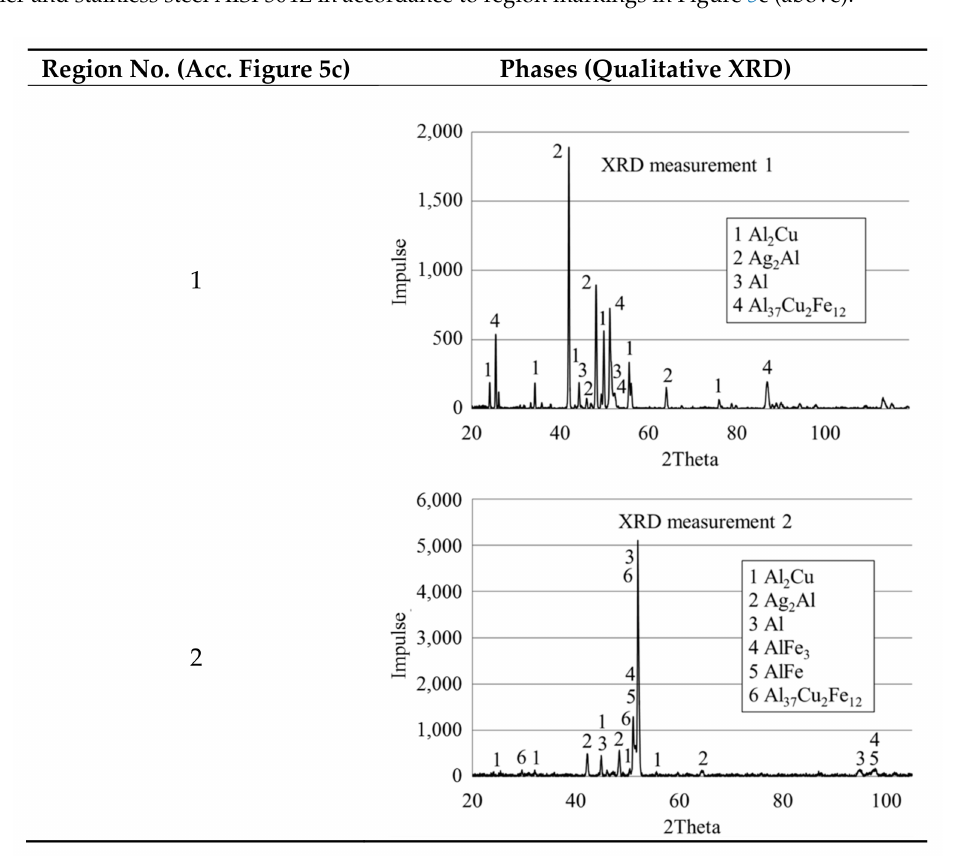
Table 4. Detected phases (XRD) in the interface of braze seams between B-Al39.5Ag39.5Cu20Si1